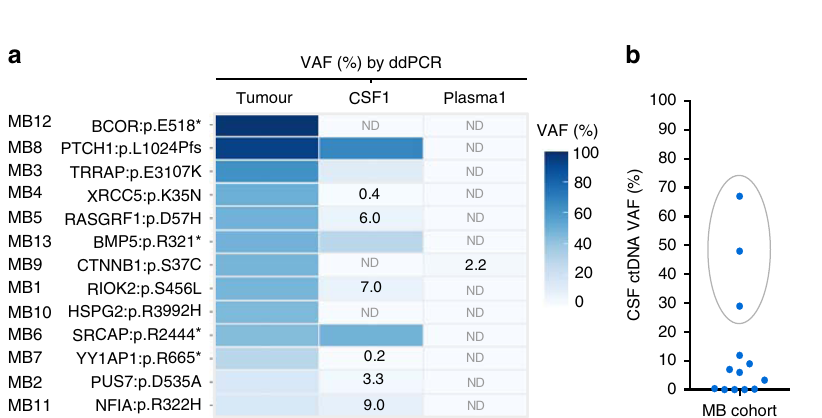
Fig. 2 ctDNA is abundant in the CSF of paediatric patients with MB. a Heatmap representing the VAFs analysed by ddPCR from tumour DNA, and CSF and plasma ctDNA samples obtained before surgical resection for the 13 patients. Colour legend for mutant allelic frequencies (VAFs) is shown. VAFs values <10% are indicated. Not detected (ND). b Distribution of CSF ctDNA VAF. Outliers identi fi ed using ROUT method are highlighted with a grey circle and selected as High CSF